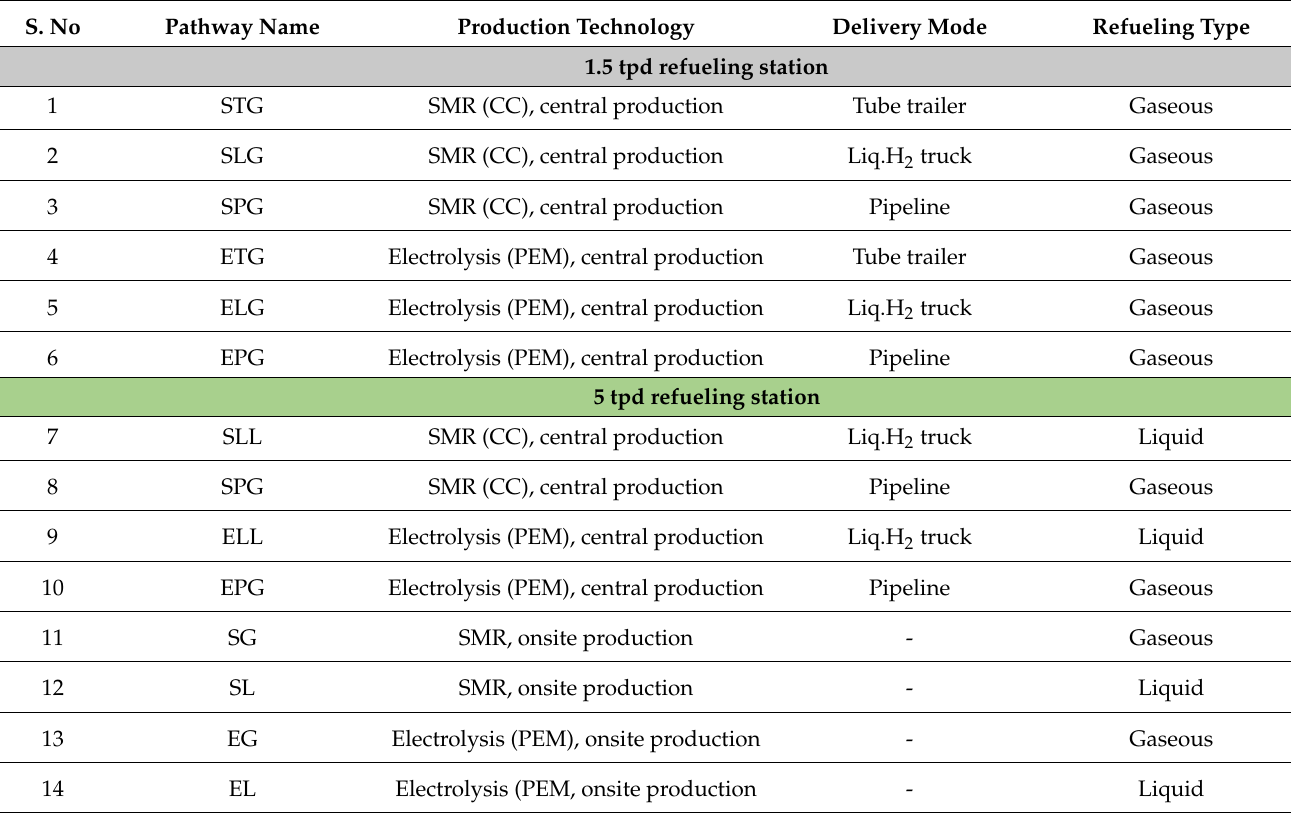
Table 4. Hydrogen pathways identified for the